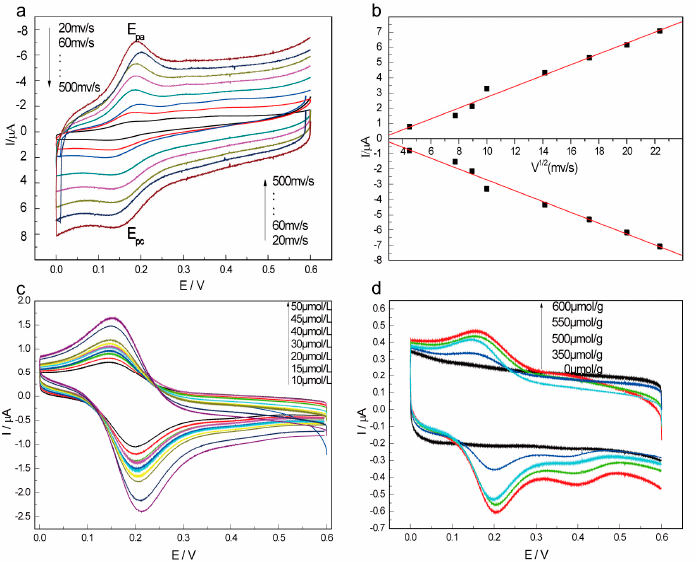
Figure 3. Electrochemical properties of β -CD-FE. ( a ) The cyclic voltammograms of the inclusion complexes at different sweep rates; ( b ) the relationship curve of peak current and square root of the scan rate; ( c ) cyclic voltammograms of the inclusion complexes at different concentration; and ( d ) cyclic voltammograms of the inclusion complexes at different inclusion amounts.